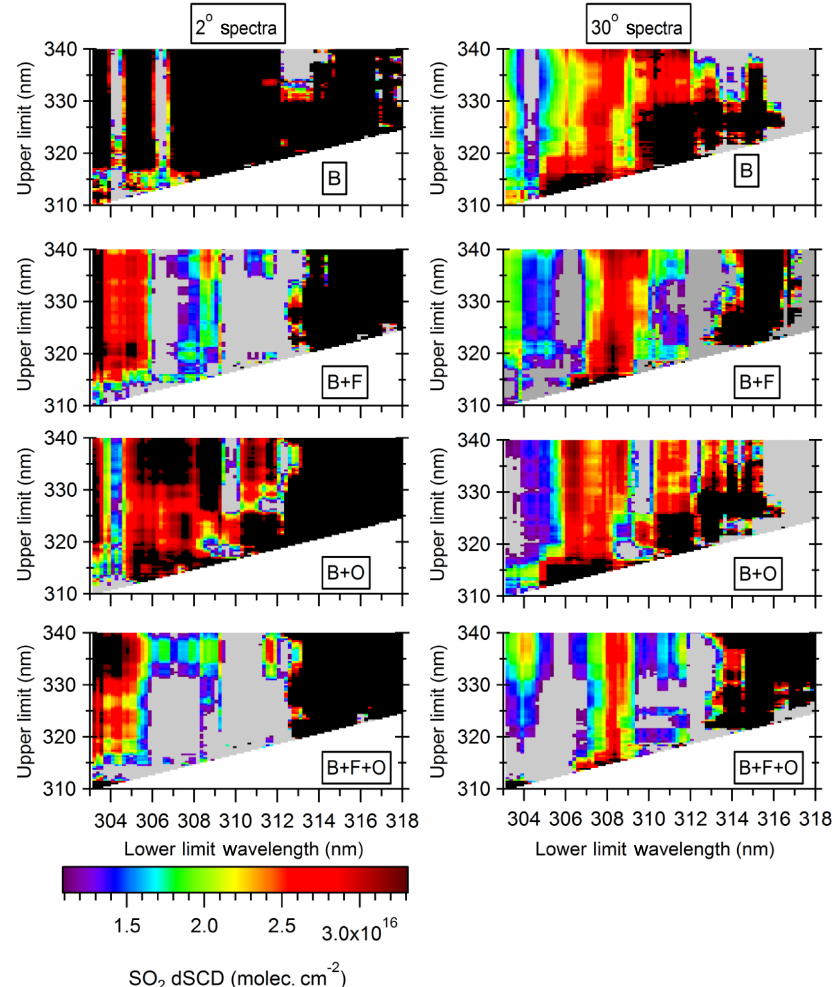
Figure 5. SO 2 dSCDs’ fit from the lower concentration measurements at 2 ◦ (left column) and 30 ◦ (right column) elevation angles for the base case, B; with the offset, B + O; with the filter, B + F; and with the filter and offset, B + F + O. Grey and black areas indicate dSCDs that were <50% less and >50% more than the expected value, respectively. The true value of the higher concentration cell is 2 . 2 × 10 16 molec.cm − 2